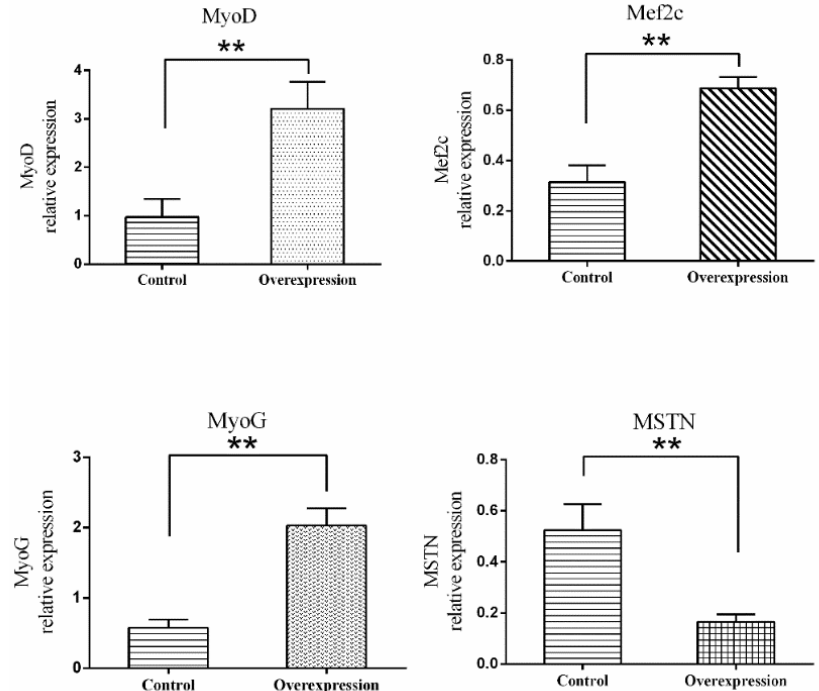
Figure 10. Expression levels of MyoD, MyoG, Mef2c and MSTN in myoblasts transfected with GV287-TCONS_00102859. To investigate the influence of the overexpression of TCONS_00102859 on myoblasts, GV287-TCONS_00102859, for which stable expression can be achieved, was used. Cells transfected with GV287-N empty vector were set as a control. We detected four genes related to muscle development. Among these, the expression levels of MyoD, MyoG and Mef2c , which had a positive impact on myogenesis, were significantly higher than those of the control ( p < 0.01). Meanwhile, the expression level of MSTN , which can inhibit myogenesis, was significantly lower than that of the control ( p < 0.01). ‘*’ represents significant difference ( p < 0.05) and ‘**’ represents extremely significant difference ( p < 0.01).